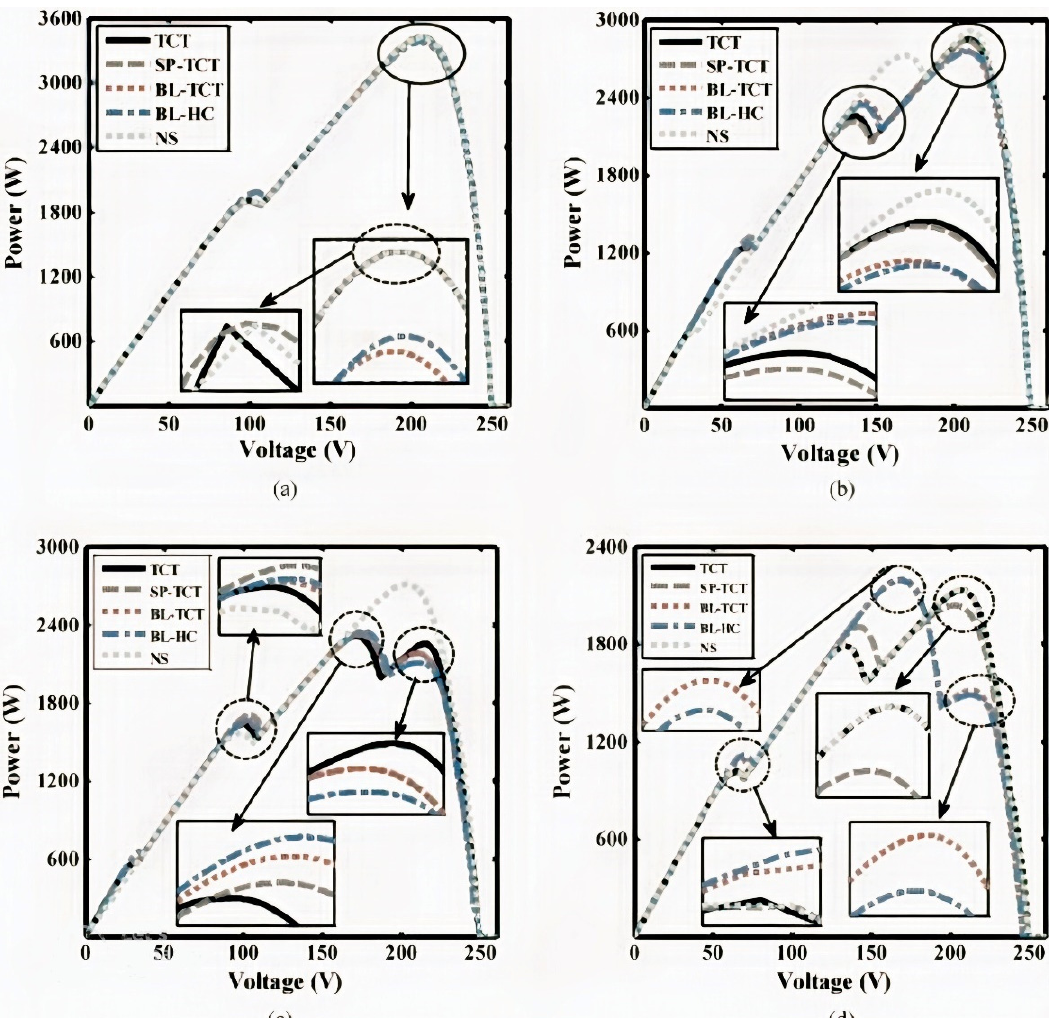
Figure 25 . Effects of various shadowing movements on P-V curves [126] . Figure 25. Effects of various shadowing movements on P-V curves